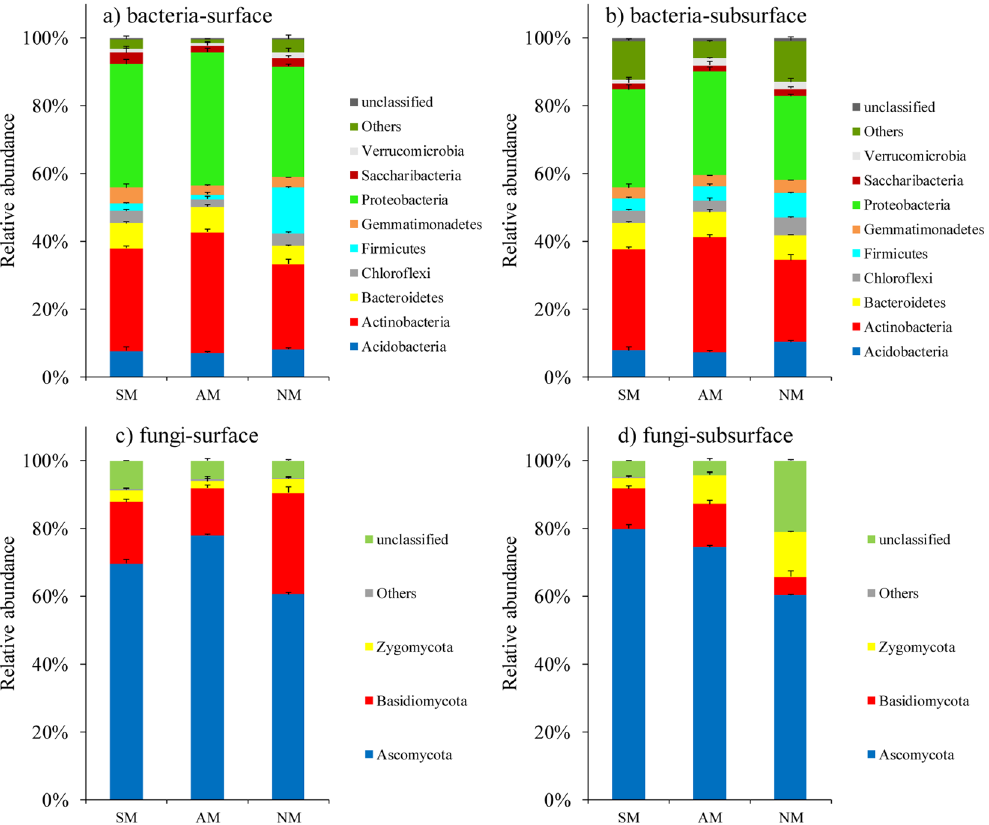
Figure 2. Taxonomic distributions of bacterial phyla in surface ( a ) and subsurface ( b ) soil samples and of fungal phyla in surface ( c ), and, subsurface ( d ) soil samples. Phyla having a mean relative abundance of at least 1% are shown individually, and less abundant phyla are grouped into